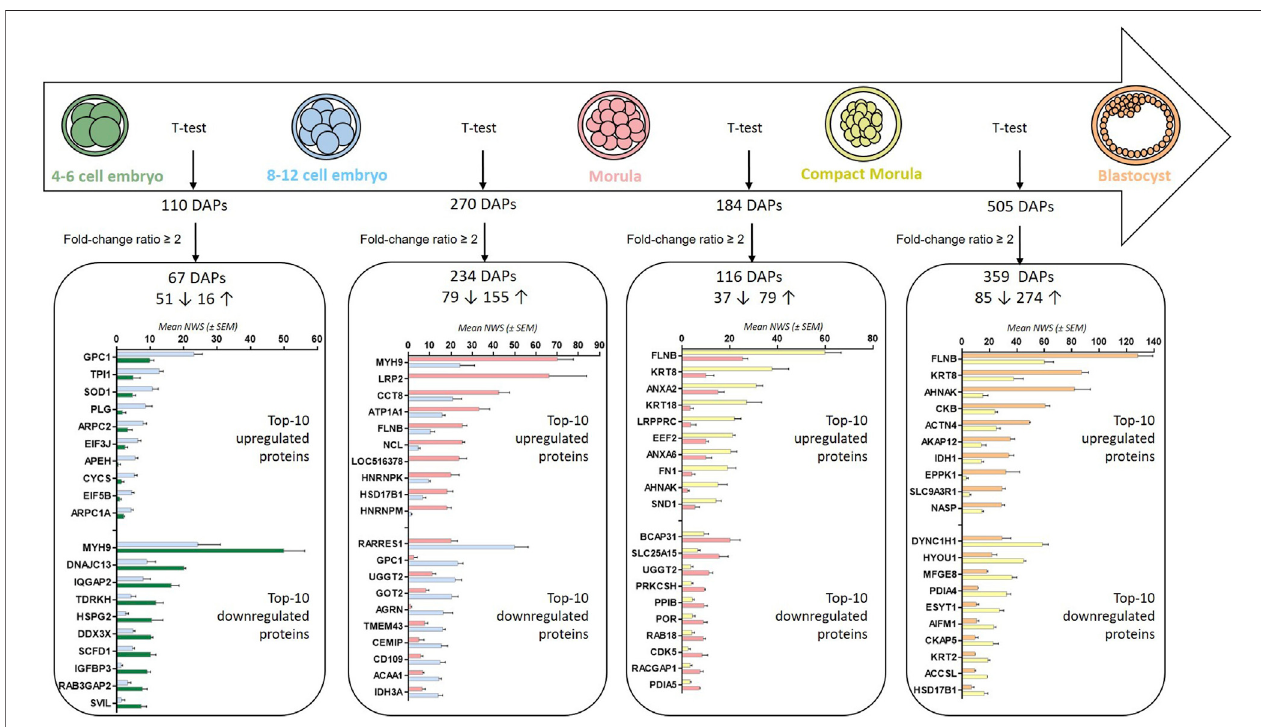
FIGURE5| Numbersandtop-20differentiallyabundantproteinsafterpairwisecomparisonsbetweenembryonicstages.NumbersofDAPsaftert-tests(p-values ≤ 0.05) and considering a min fold-change ratio of 2 are presented. Numbers before rising and downward arrows indicate upregulated and downregulated proteins, respectively. The histograms indicate the top-10 upregulated and downregulated proteins in each comparison.